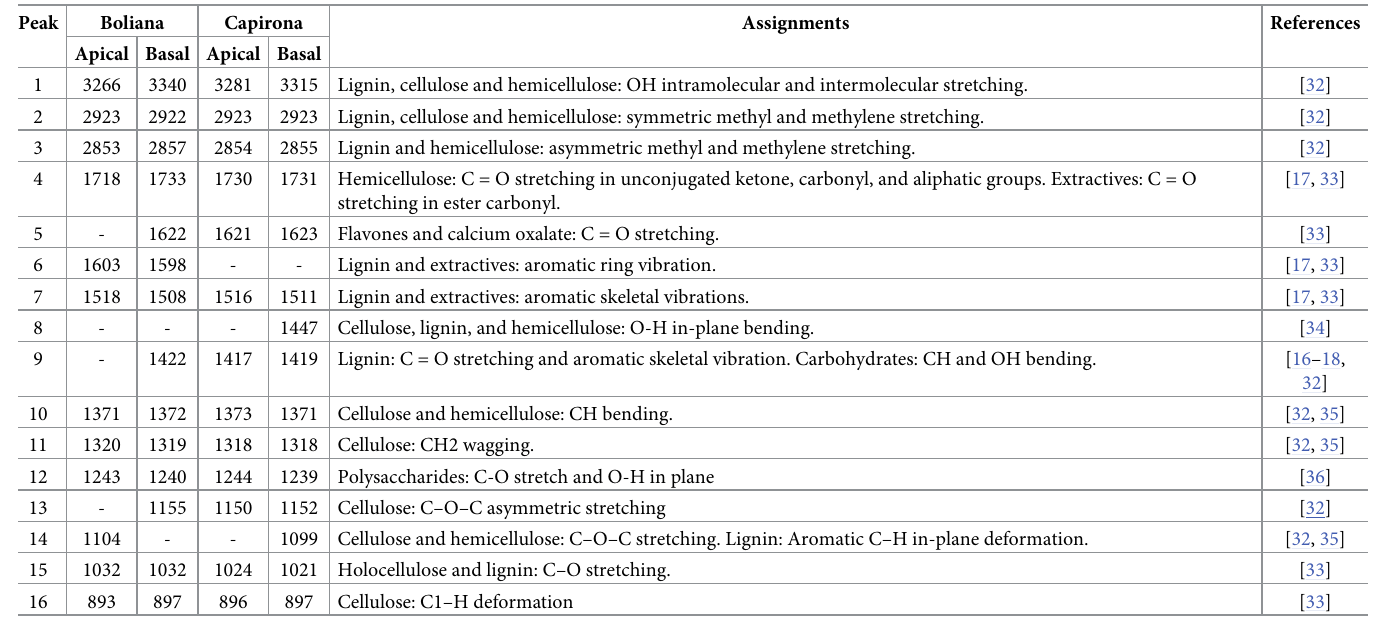
Table 2. Assignment of peaks in FTIR spectra of C . spruceanum and G . crinita